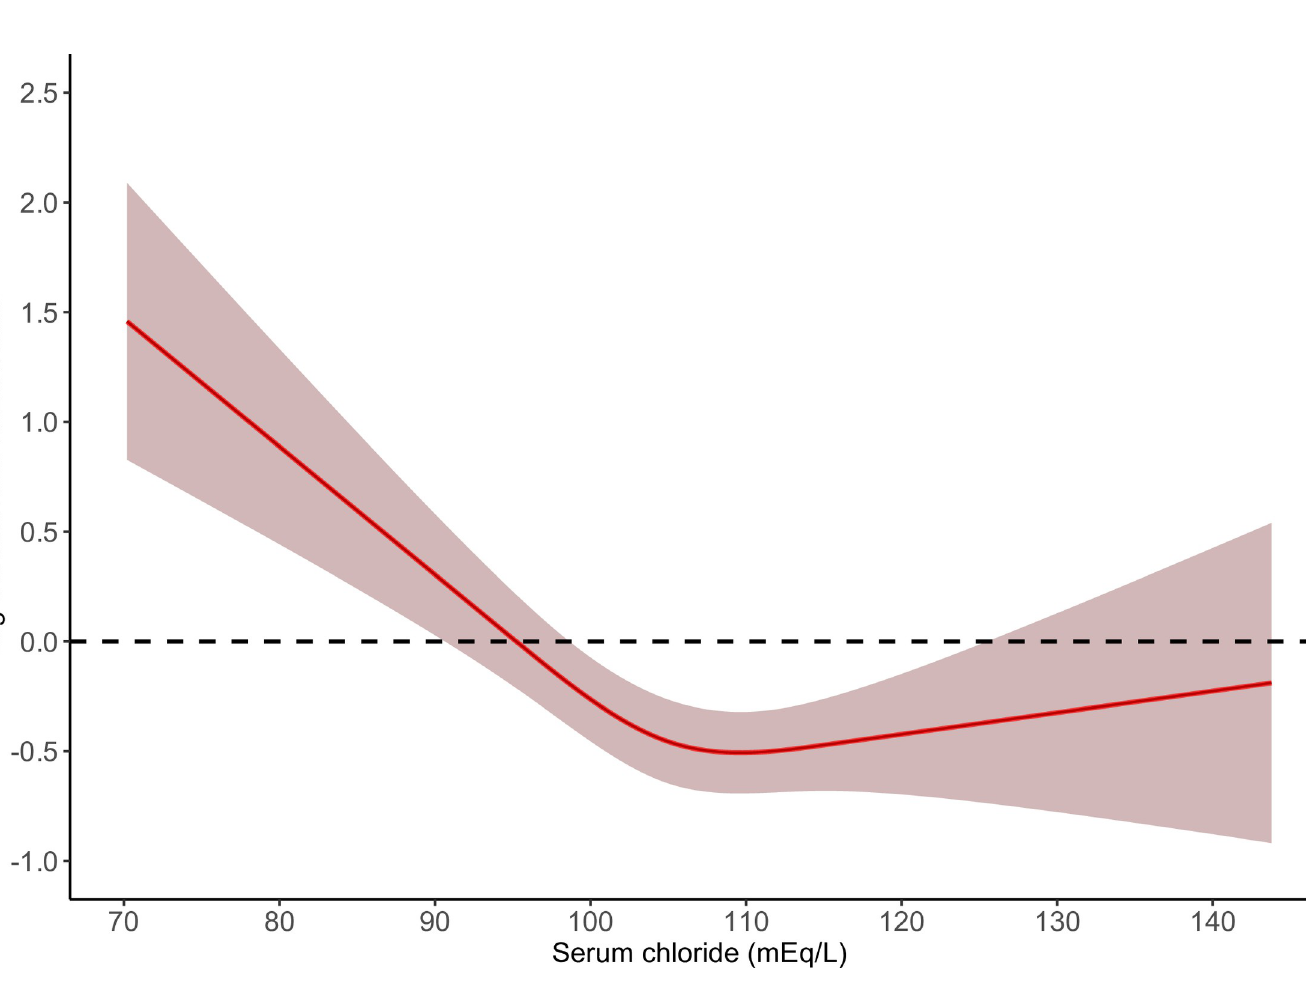
Fig 2. The smoothing curves of in-hospital mortality of critically ill AKI patients against serum chloride. The solid red lines represent the effect estimates and the shaded area represents 95% confidence intervals. P for non–linearity = 0.0001. Abbreviations: AKI, acute kidney injury.